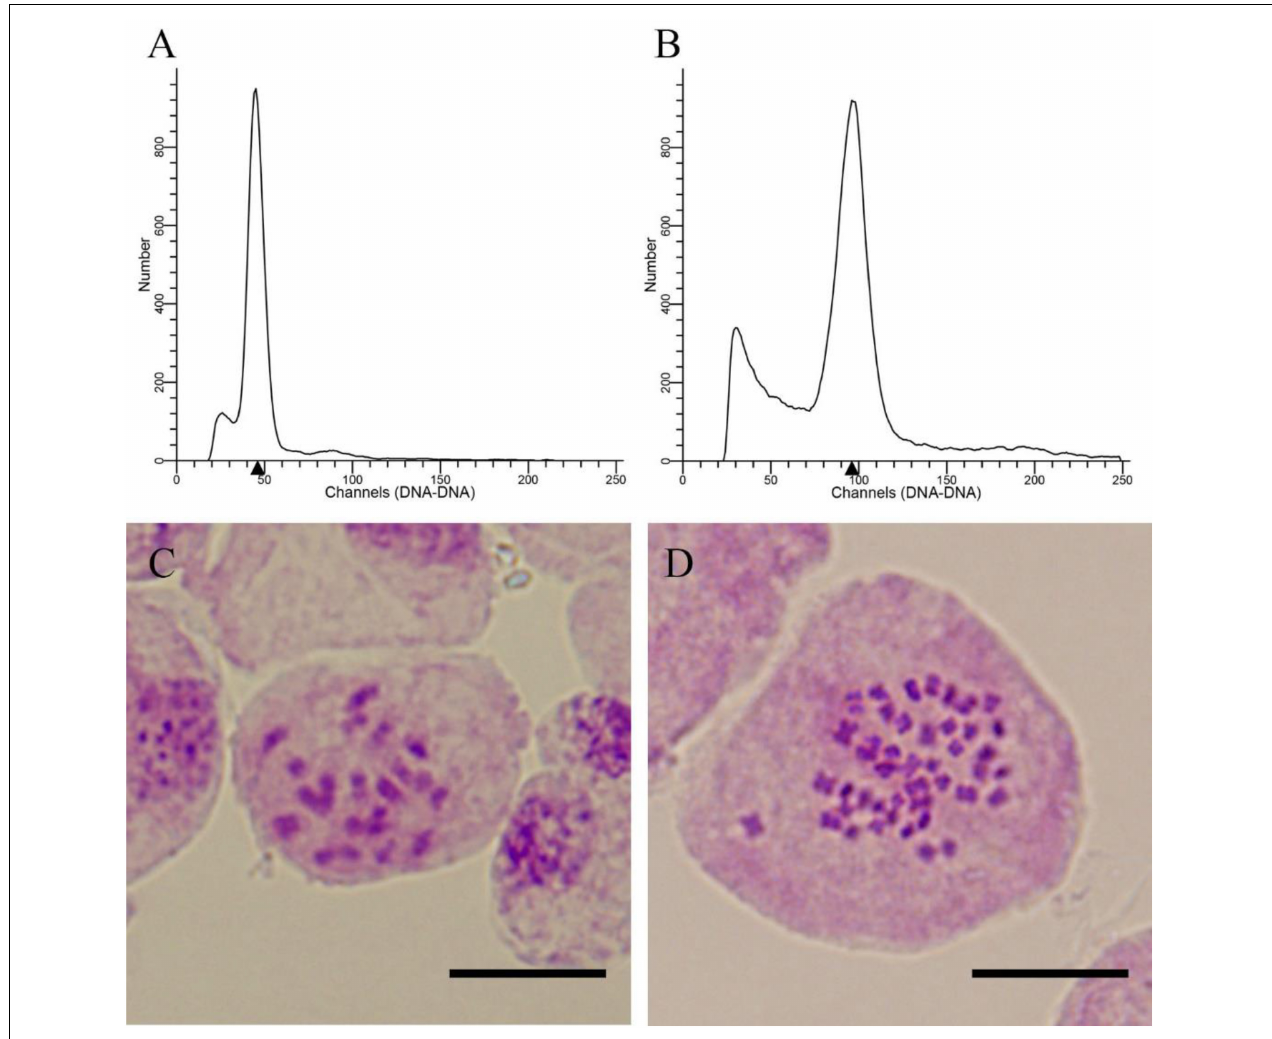
FIGURE 2 | Ploidy level detection of E. urophylla offspring. (A) Histogram of the flow cytometry results for diploids; (B) histogram of the flow cytometry results for the tetraploid; (C) somatic chromosome counting for the diploid (2n = 2 × = 22); and (D) somatic chromosome counting for the tetraploid (2n = 4 × =